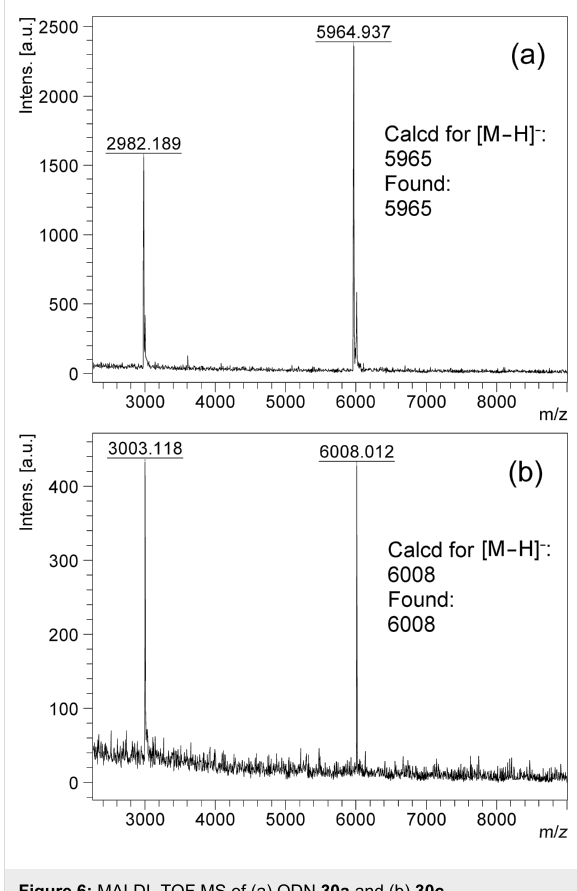
Figure 6: MALDI–TOF MS of (a) ODN 30a and (b) 30c .